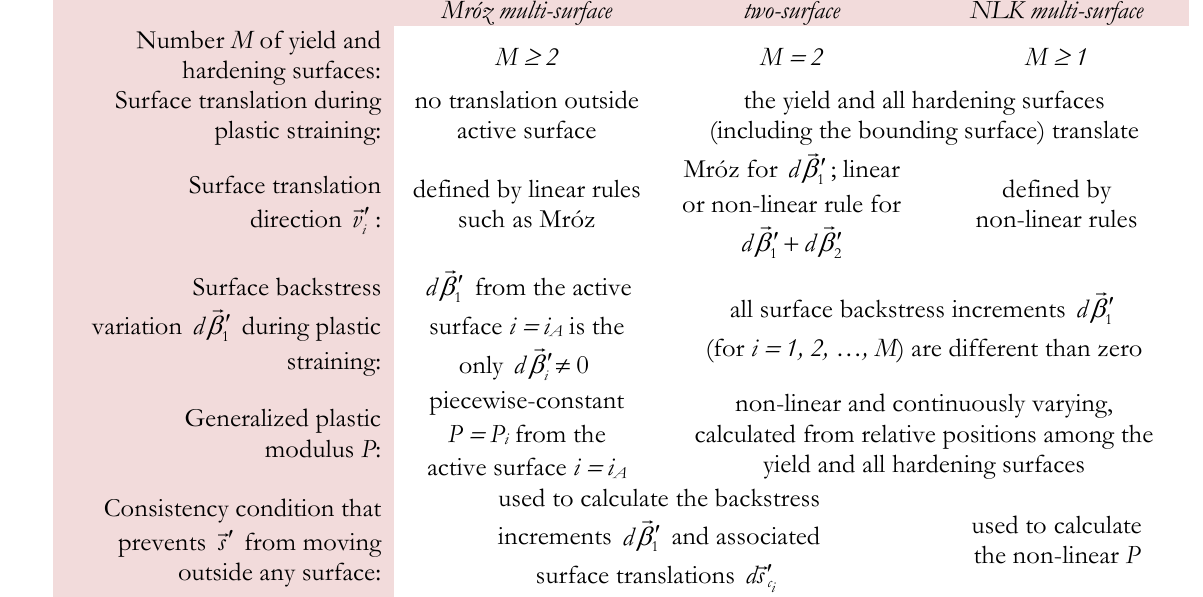
Table 2: Comparison among the Mróz multi-surface, two-surface, and NLK multi-surface model formulations, to predict multiaxial kinematic hardening